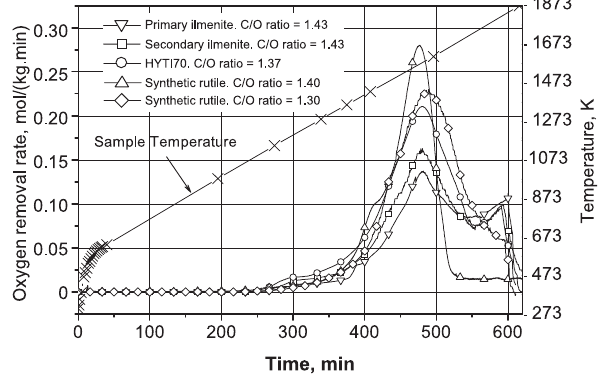
Fig. 6: Temperature programmed reduction of ilmenite concentrates and synthetic rutile in N . The temperature was ramped from 673 to 2 1873 K at 2 K/min.